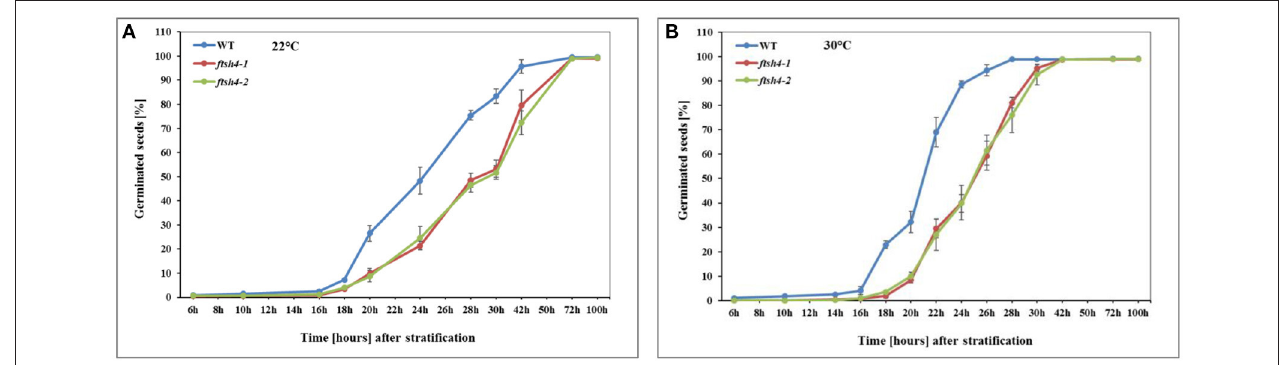
FIGURE 2 | Germination rate of wild-type (WT) and ftsh4 mutant seeds under long-day photoperiod and 22 ◦ C (A) and 30 ◦ C (B) . In all experiments, seeds were sowed on a black nitrocellulose membrane wetted with sterile distilled water, stratified for 48h at 4 ◦ C in the dark and then incubated under 16-h light and 8-h dark (long-day photoperiod, LD) conditions at 22 ◦ C or 30 ◦ C. Seeds were scored every several hours until germination rate reached over 98%. A seed was considered as germinated after the emergence of the radical tip through the seed coat. (A) Germination of WT and ftsh4-1 and ftsh4-2 mutants under LD, 22 ◦ C. Data are mean ± SD of four independent biological replicates ( n = 4, 140–180 seeds of each type). (B) Germination of WT and ftsh4-1 and ftsh4-2 mutants under LD, 30 ◦ C. Data are mean ± SD of five independent biological replicates ( n = 5, 100–200 seeds of each type).